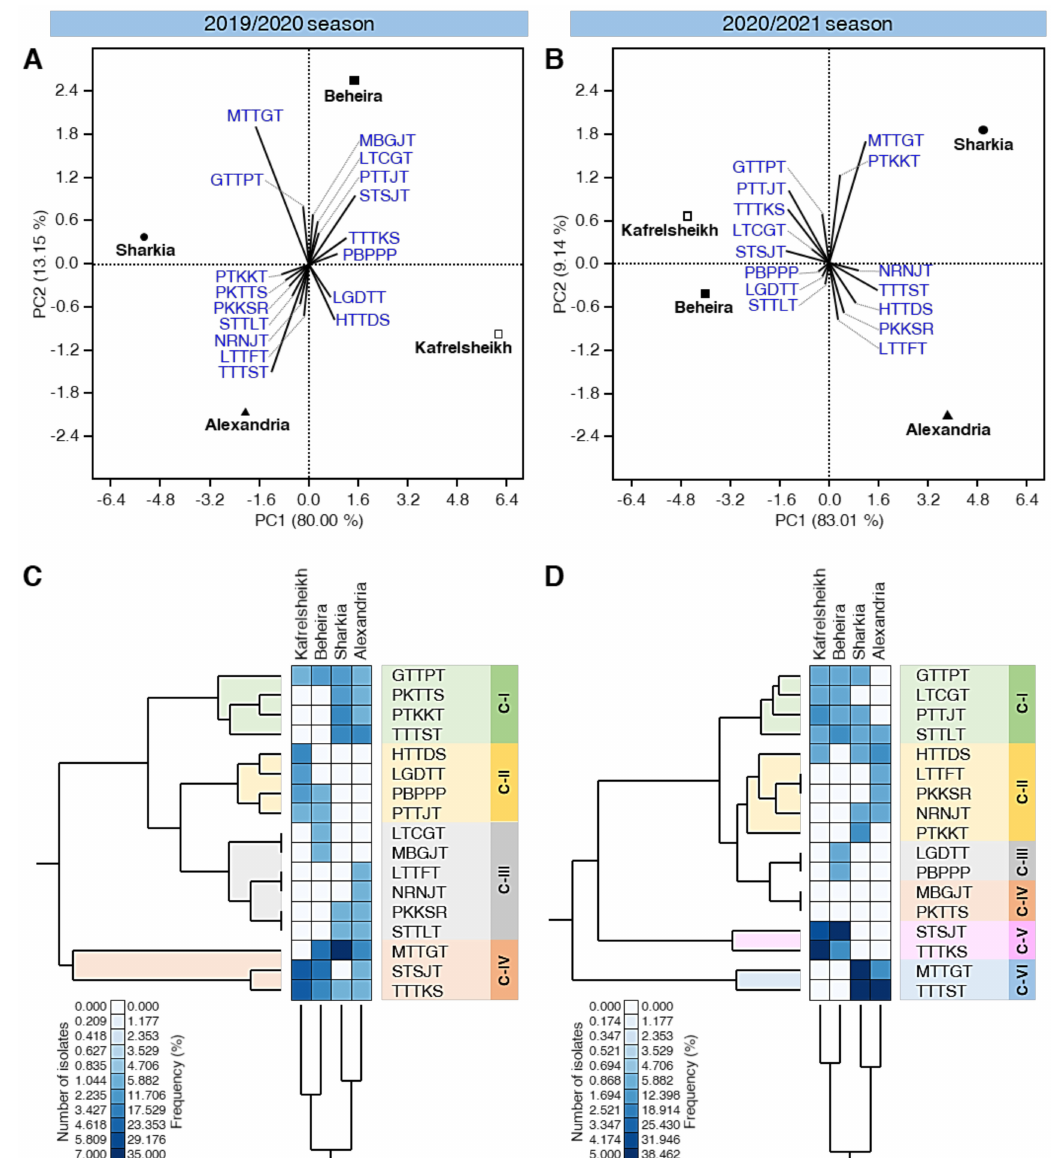
Figure 3. Principal component analysis (PCA) and two-way hierarchical cluster analysis (HCA) of individual physiological races of P. triticina detected in four main wheat-growing governorates in Egypt during the 2019/2020 and 2020/2021 seasons. ( A , B ) PCA-scatter plots and their associated loading plots using data collected during 2019/2020 and 2020/2021 seasons, respectively. ( C , D ) Standardized two-way HCA based on the number of isolates and frequency (%) of 17 individual physiological races of P. triticina from four main wheat-growing governorates in Egypt during 2019/2020 and 2020/2021 seasons, respectively. The differences in the number of isolates and frequency (%) are visualized in the heat map diagram. Rows represent the individual physiological races, while columns represent the locations/ governorates. Low number of isolates and frequency (%) are colored light-blue and the high number of isolates and frequency (%) are colored dark-blue (see the scale at the left corner of the bottom of the heat